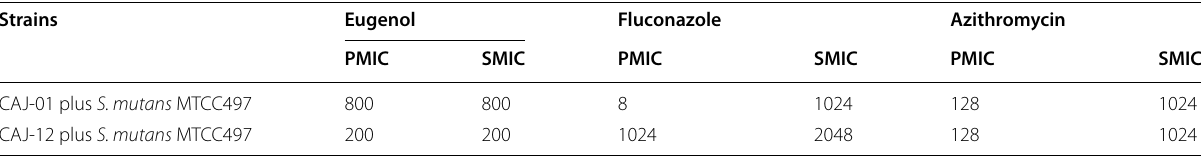
Values of PMIC and SMIC are given in µg/mL